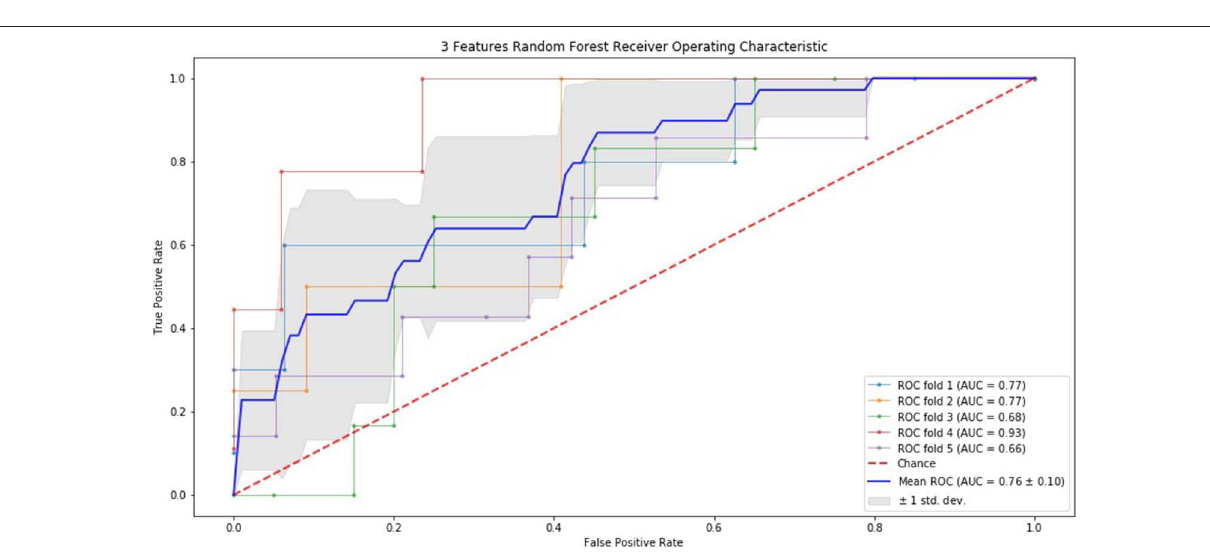
FIGURE 4 | ROC of 5-fold cross validation results of RF. The mean AUC of 3 features was 0.76 ±